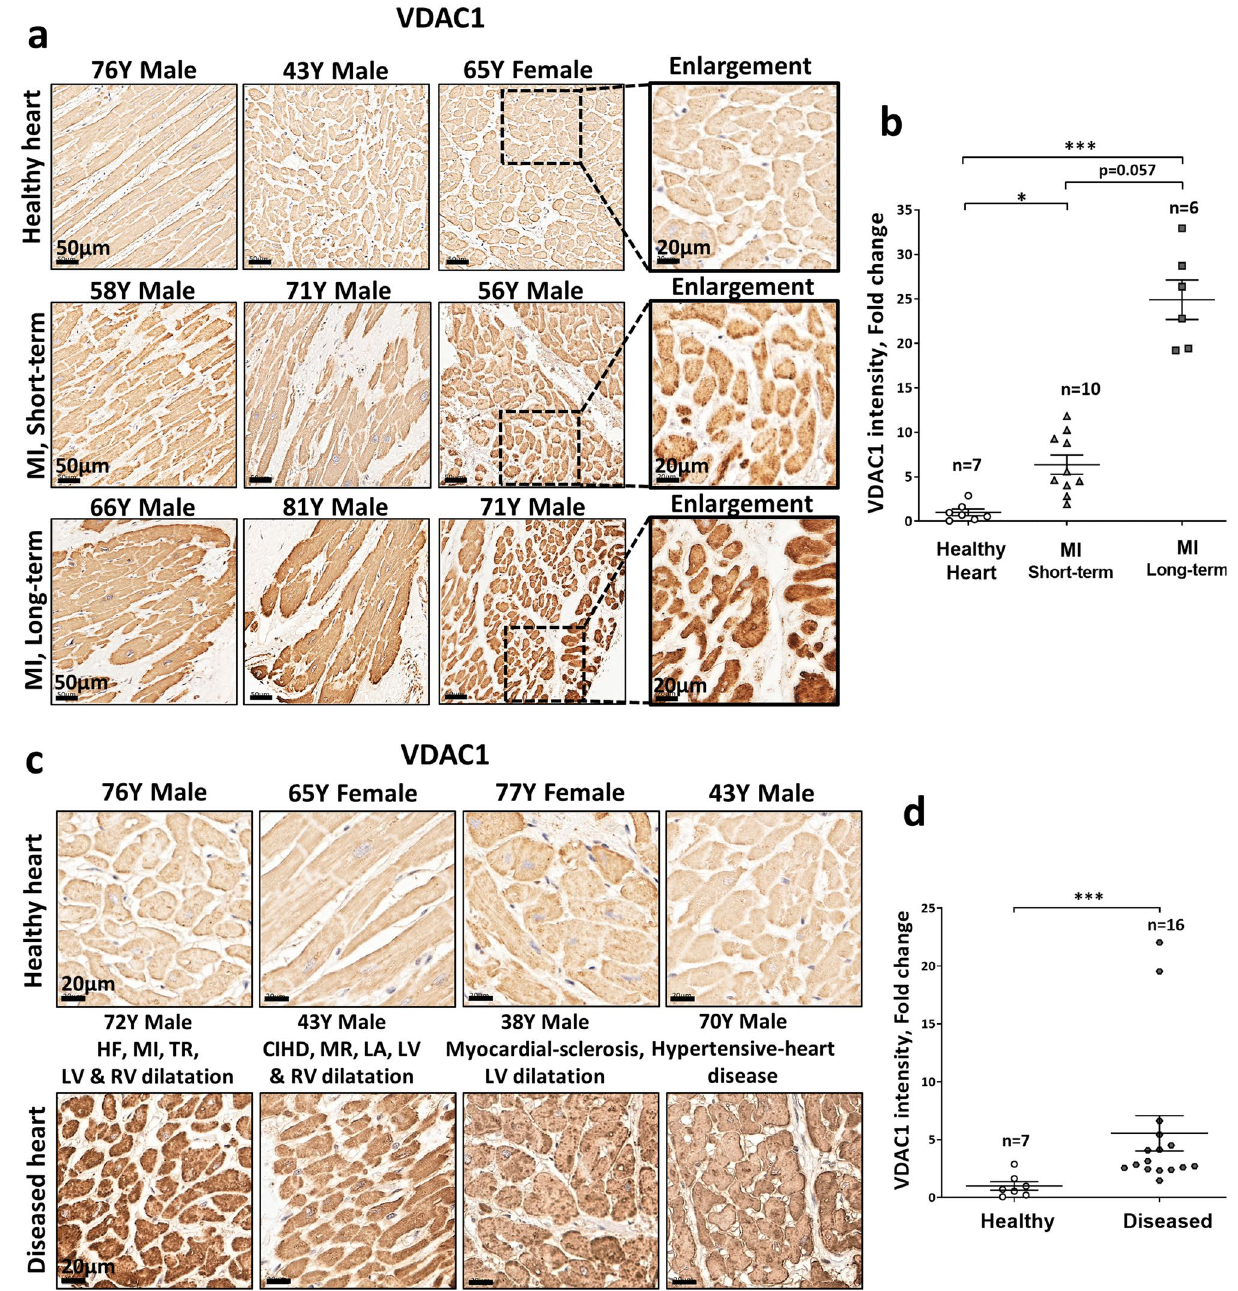
Figure 1. Overexpression of VDAC1 in human cardiac pathologies. ( a , b ) VDAC1 IHC staining in the left ventricle (LV) of patients post myocardial infraction (MI) relative to hearts without known cardiac disease. IHC staining presented as fold change relative to the mean intensity of the control samples. “MI short-term” represents samples defined as acute MI or granulation tissue. “MI long-term” represents the samples in which clinical data indicated the presence of scar tissue. Only non-infarcted zones with viable myocardium were analyzed. ( b ) Representative photomicrographs for each condition. Scale bars, 50 µm and enlargement of 20 µm. ( b ) Summarizing scatter plot of quantitative image processing analysis. Note gradual increase in VDAC1 expression levels between MI long-term and MI short-term. Also note, punctuated staining suggesting mitochondrial localization of VDAC1. ( c , d ) VDAC1 IHC staining in the LV of patients with cardiac diseases involving dilatation\hypertrophy. HF—Heart failure, TR—tricuspid regurgitation, RV—Right ventricle, CIHD—Chronic ischemic heart disease, MR—Mitral regurgitation. ( c ) Representative photomicrographs for each condition. Scale bars, 20 µm. ( d ) Summarizing scatter plot of quantitative image processing analysis. Note, overall increased expression of VDAC1 in the various pathologies. The number of samples in each group is indicated (n =